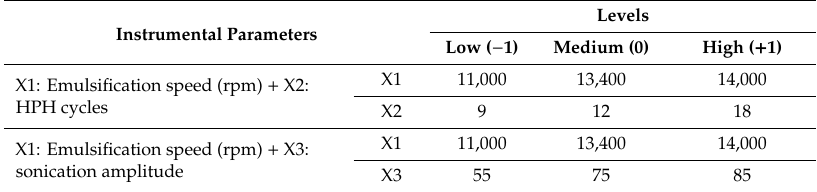
Table 2. Design of experiment (DoE) using Box–Behnken design (BBD) to optimize rivastigmine-loaded nanostructured lipid carriers (NLC) formulations using di ff erent combinations of critical process parameters